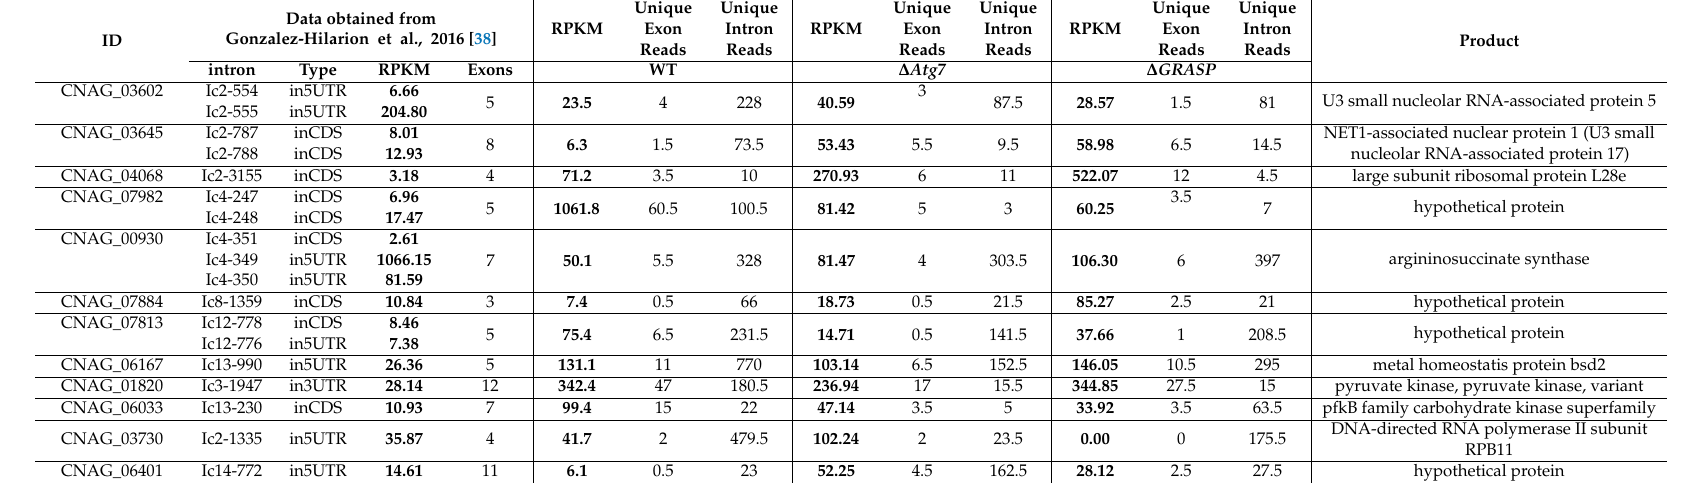
Table 3. Intron retention in EV